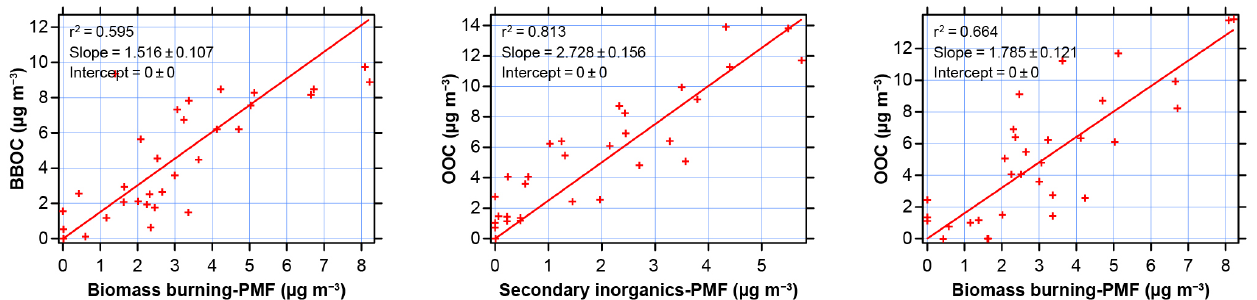
Figure 7. Correlations observed between PMF and offline AMS–PMF results at IAP (winter).